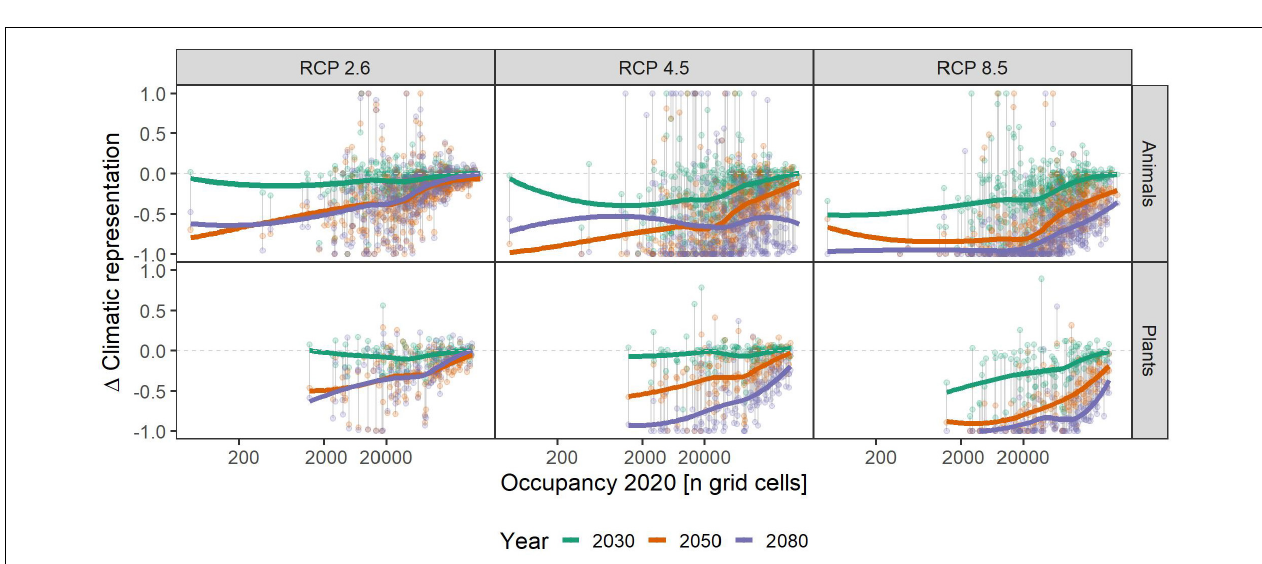
FIGURE 2 | Proportional representation of climatic niches in PAs across all 530 endemic plant and animal species considered in this study. Shown are estimates and 95% confidence intervals (CI) from a generalized linear mixed effects model including a significant interaction between time-step, scenario and taxonomic groups. Please note that all data presented here come from a single model, even though the taxonomic groups are displayed in two separate panels for overview. The different colors represent the climatic scenarios RCP 2.6, RCP 4.5, and RCP 8.5, while the hindcast represents the current climate (i.e., year 2020). Numbers on the x-axis refer to the modeled year with 20, 30, 50, and 80 referring to the years 2020, 2030, 2050, and 2080, respectively. Pair-wise contrasts (Tukey-method corrected) are statistically significant at p < 0.005 (letters).